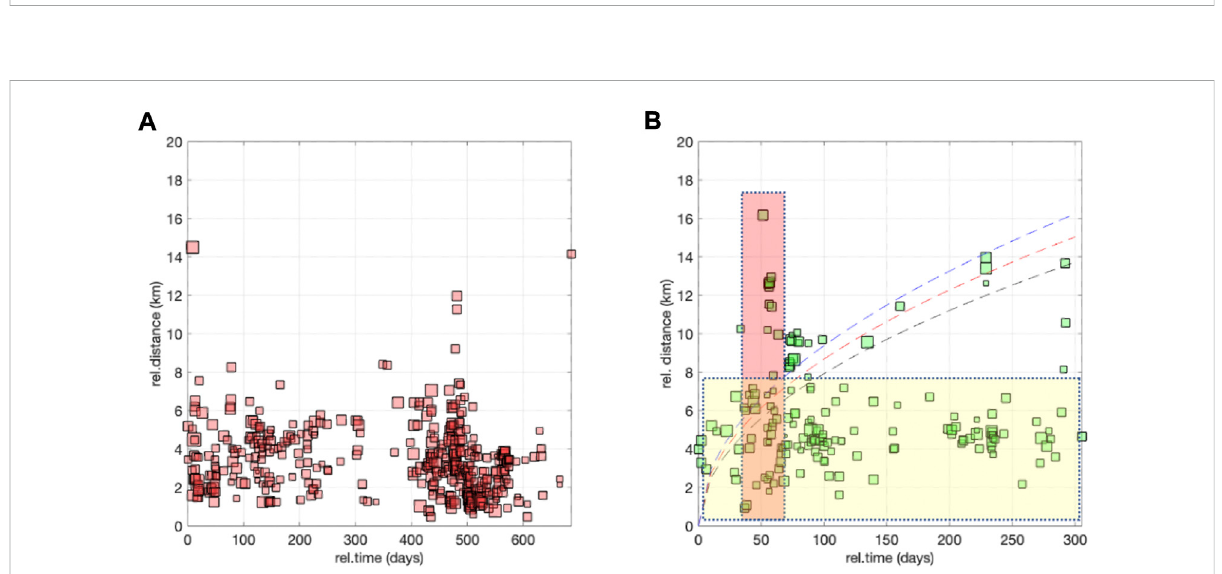
FIGURE 7 (A) Distributionofperiod # 1events;relativedistancevs.relativetimefromthe fi rstevent. (B) Thesameas (A) ,butforperiod # 2.Here,wehighlight the trends corresponding to a diffusivity equal to 0.05, 0.06, or 0.07 m 2 /s (black, red, and blue dashed lines, respectively). Moreover, we highlight a periodwitheventscoveringanarrow rangeofrelativedistances,butahighrelativetime(suchasperiod # 1;yellowrectangleitissingular), aswellasa second area with a high range of distances in a narrow period of time (red rectangle it is